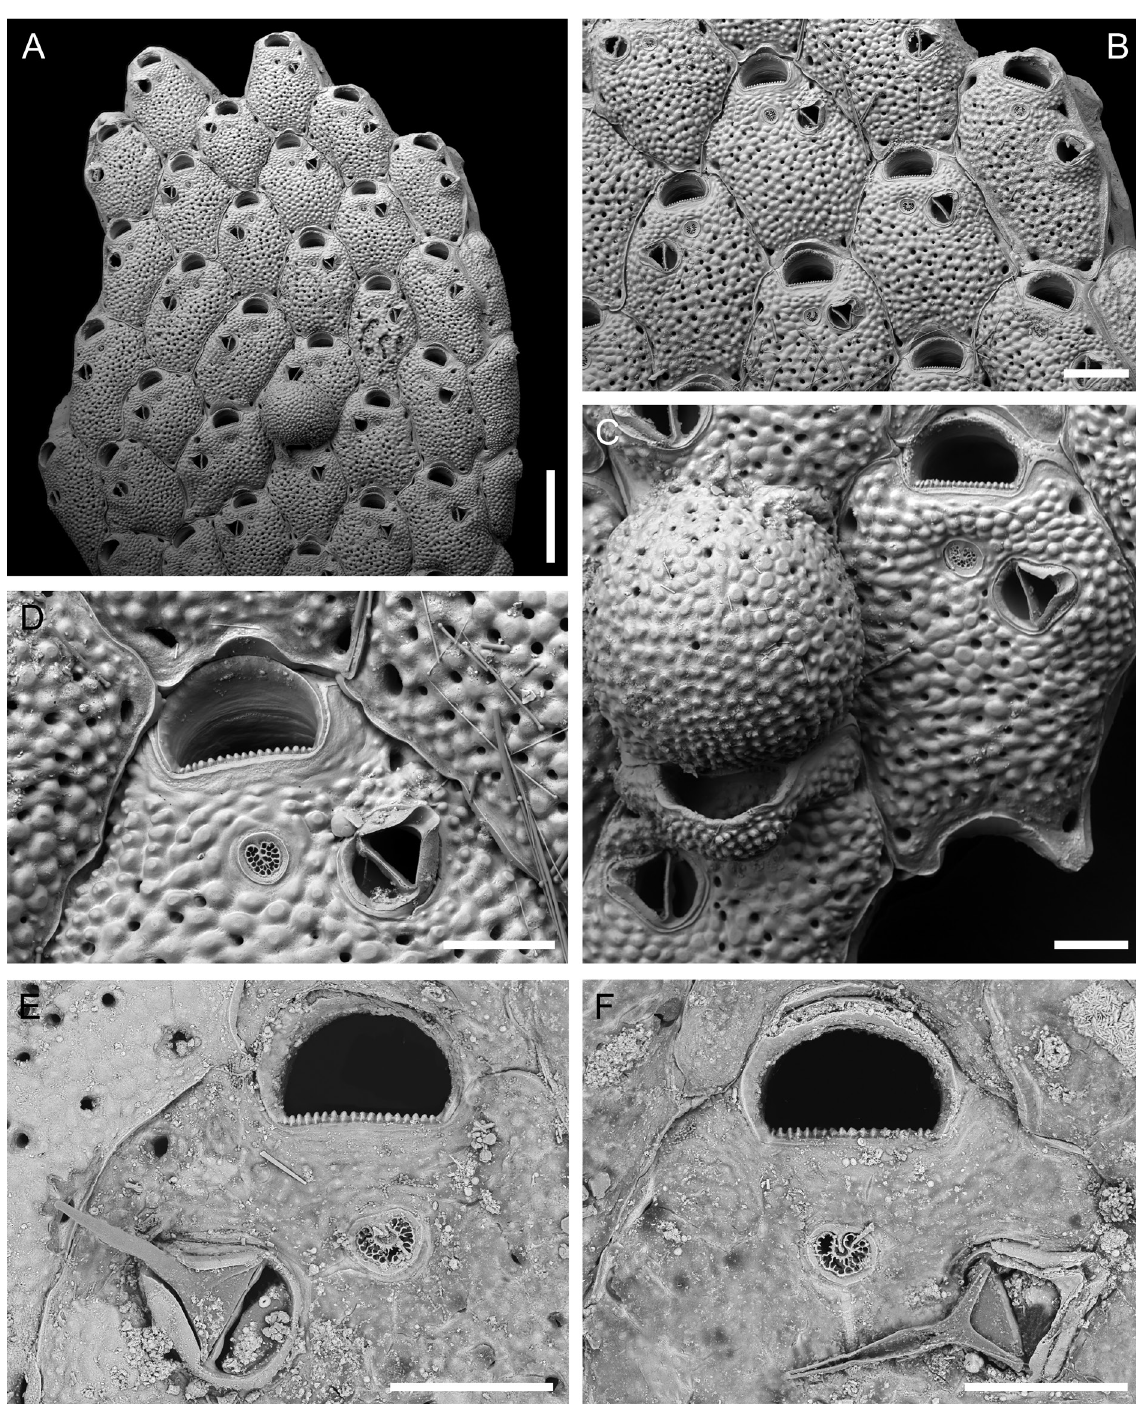
Fig. 8. Microporella ordoides sp. nov. A–D . Holotype NIWA 144883, Recent, New Zealand. A . Group of zooids at the branch tip. B . Close-up of autozooids. C . Close-up of the orifice, ascopore and adventitious avicularium. D . Close-up of an autozooid and ovicell. E–F . Paratype NIWA 119893 (unbleached), Recent, New Zealand. Two avicularia with closed and open mandible, respectively. Scale bars: A = 500 µm; B = 200 µm; C–D = 100 µm; E–F = 150